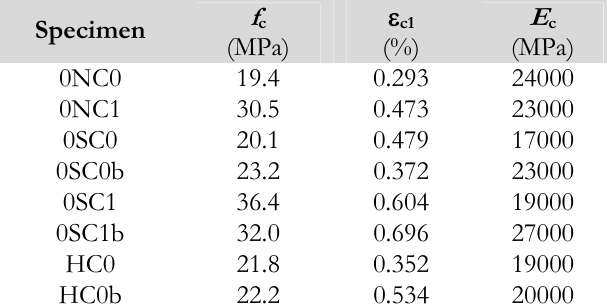
Table 3: Mechanical properties measured in the